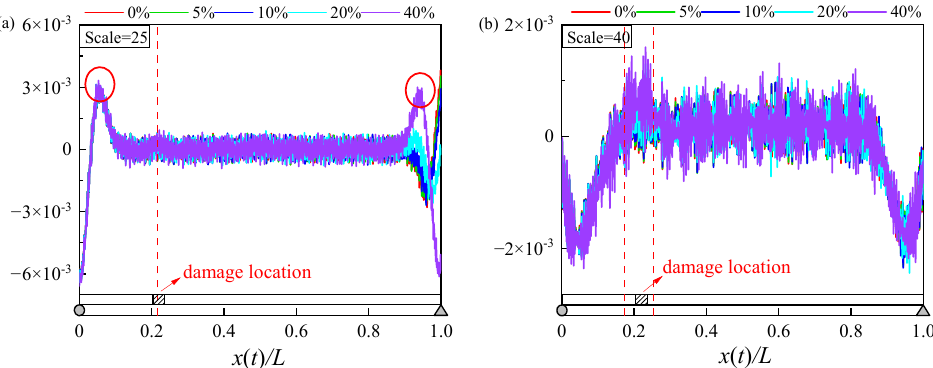
Figure 6. Wavelet coefficient diagram: ( a ) bridge mid - span acceleration; ( b ) contact ‐ point accelera ‐